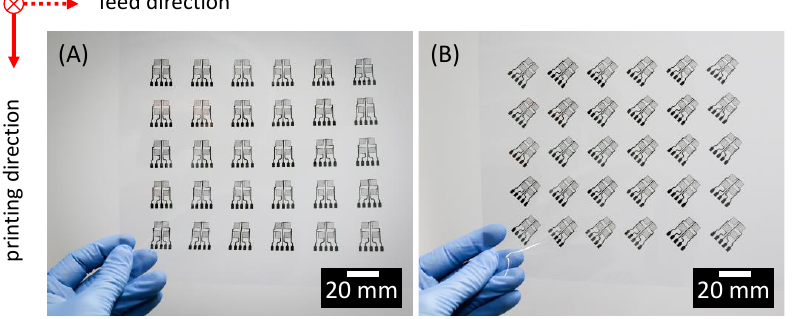
Figure 9. Photograph of printed and sintered SG full bridges on PEN film: ( A ) reference, not rotated, pixel grid; ( B ) rotated by 45°, diagonal grid.